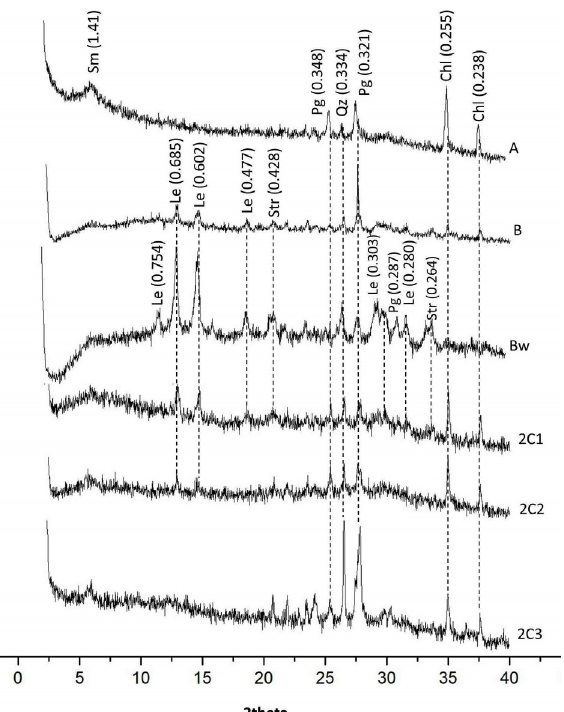
Figure 3. XRD spectrum of clay fraction within the pedon P2 (MT-1). Chl: chlorite, Sm: smectite, Ko: kaolinite Pg: plagioclase, Qz: quartz. “d” in nm.